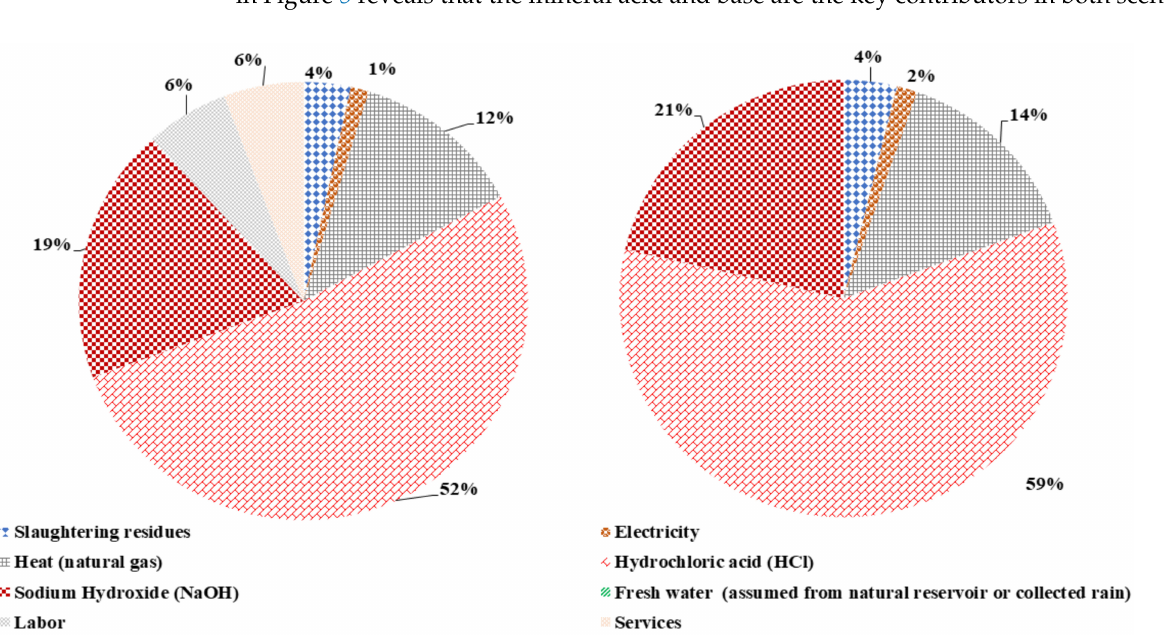
Figure 5. Contribution of different input flows for the emergy content of hydrolysis with and without